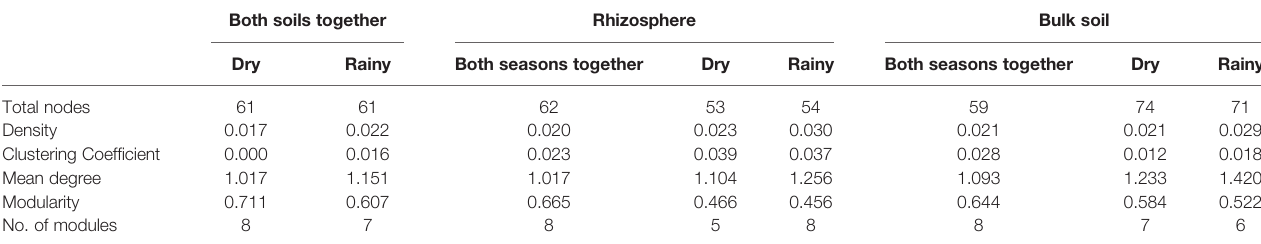
TABLE 2 | Global network measures obtained from real (consensus) and random networks. Both soils